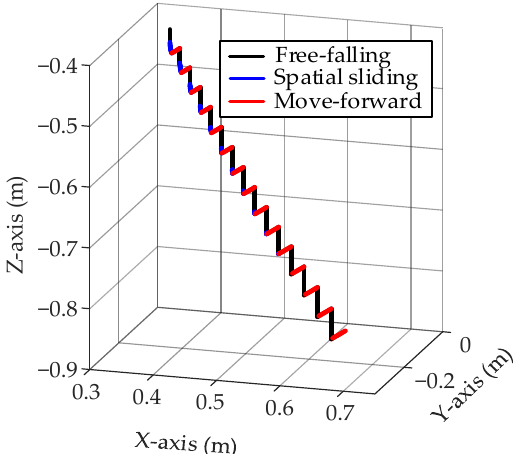
Figure 12. The path of particles in the crushing chamber of CF11 hydraulic cone crusher. As shown in Figure 12, the particles are discharged from the crushing chamber after 15 times of crushing. In the dynamic crushing process of particles, there are nine times of falling with the motion characteristic of the spatial compound falling and six times of falling with the motion characteristic of free-falling. The particles deflect circumferentially around the central axis of the cone crusher with the decrease in height. When the particles are discharged from the crushing chamber, the circumferential deflection angle is 4.35°. If the rotating speed of the main shaft of the cone crusher is changed, the particles in the crushing chamber will have different motion characteristics, resulting in a change in the path of the particles. If the rotating speed of the main shaft of the CF11 hydraulic cone crusher is changed to 267 rpm and 425 rpm, the path of the particles in the crushing chamber can be obtained according to the improved model, as shown in Figure 13.